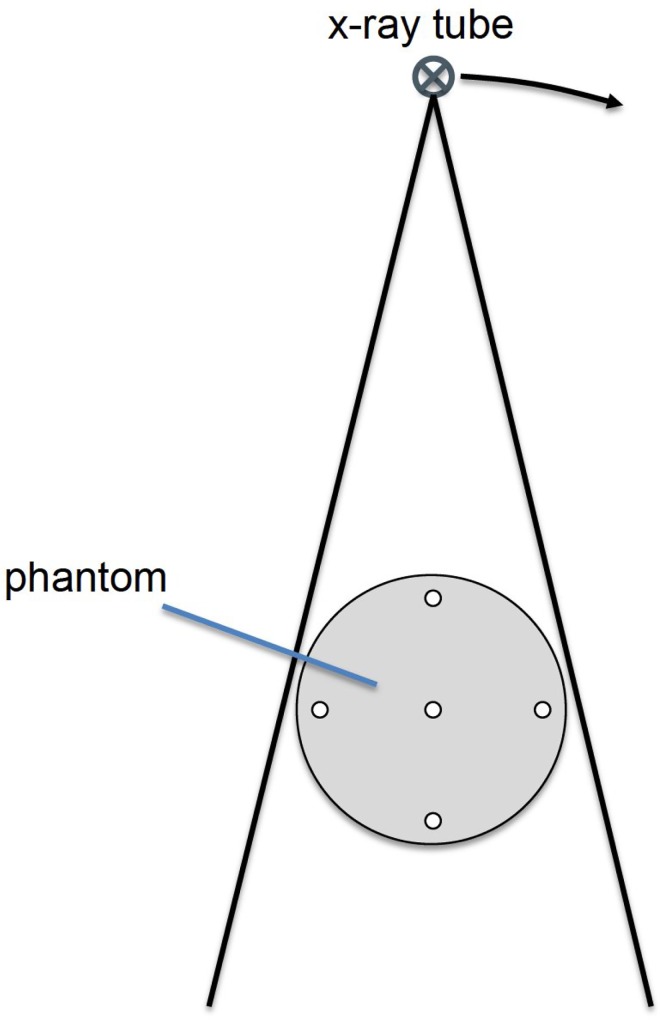
Setup of calibration and validation for Monte Carlos system and experiment.Dose was measured at the five holes with a pin-point chamber in the center of the phantom.